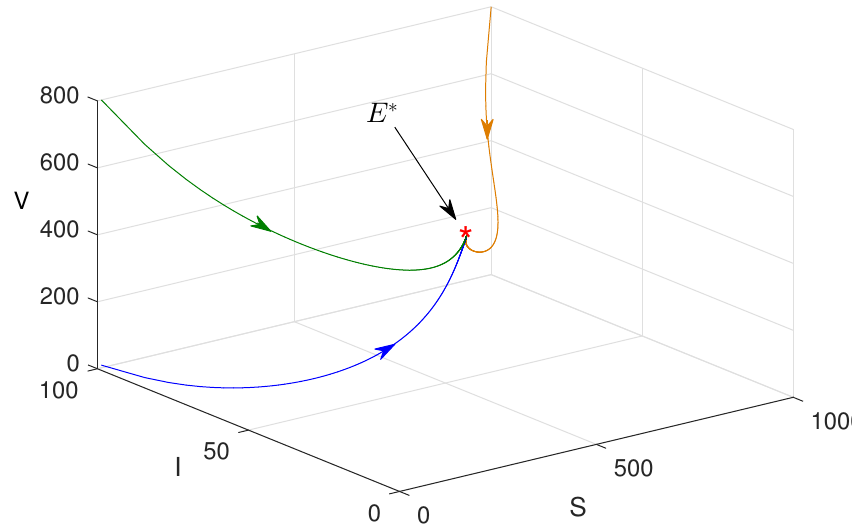
Figure 5. Phase portrait in S–I–V plane for three different initial conditions. In this figure, α = 0.8; others parameters are same as in Figure 4. Colored lines are obtained from three different initial